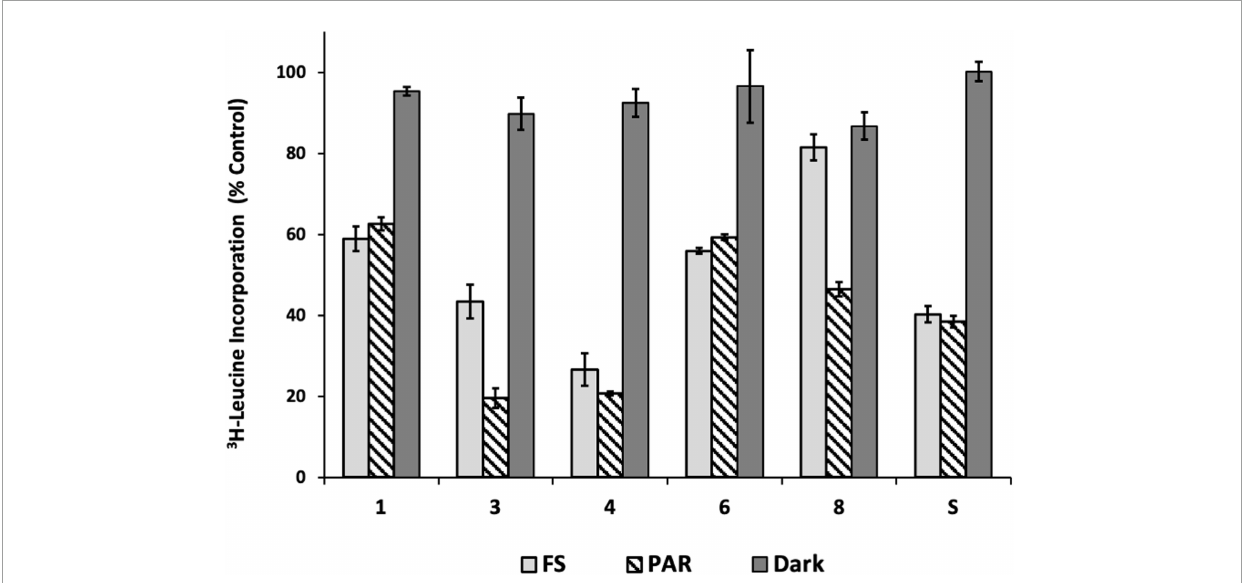
FIGURE4 Inhibition of bacterial production ( 3 H-Leucine incorporation) as a result of light exposure during WAF preparation. Significance levels of pairwise comparisons (WAF made in FS treatment vs. WAF made in dark, and PAR treatment vs. dark WAF) are indicated (p level indicators here). Inhibition of bacterial production ( 3 H-Leucine incorporation) is expressed as a percent of the control. P -values for multiple comparisons within and between oils are in the [Headrick (2019); Supplementary Data Spreadsheet ].